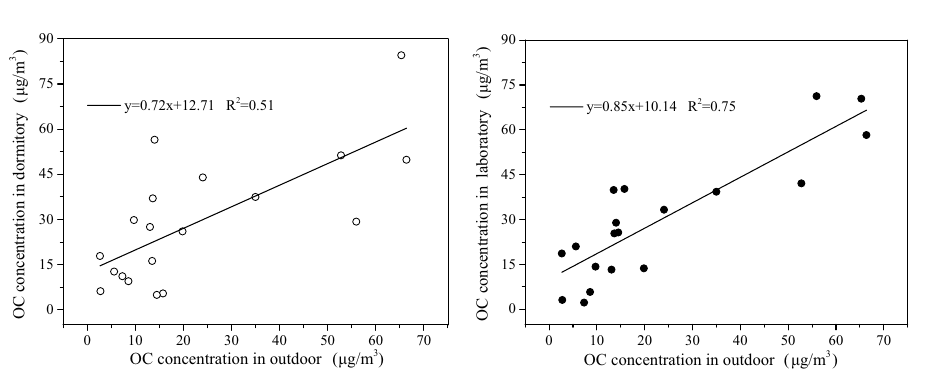
Figure 4. The regression analysis of OC concentration for dormitory and outdoor, laboratory and